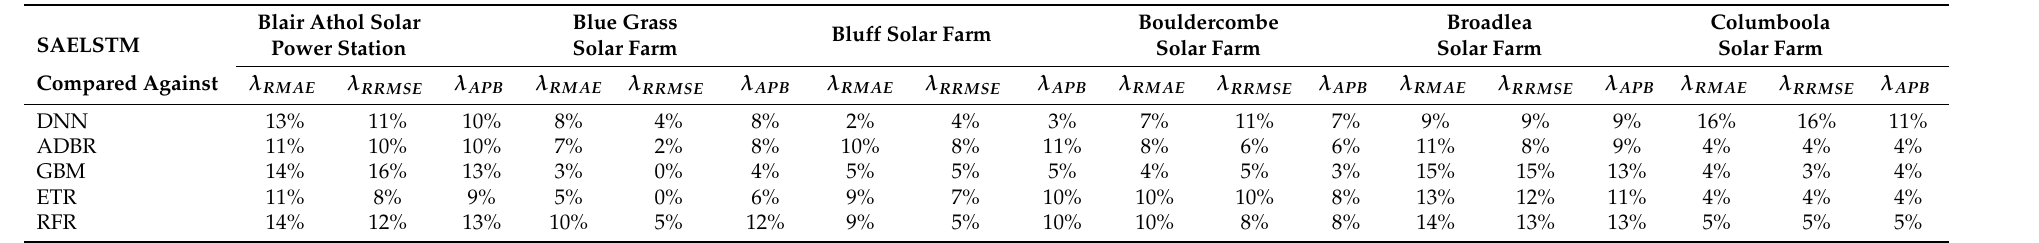
Table 8. The promoting percentage of comparison, against objective (i.e., deep learning hybrid SAELSTM) model with percentage values indicating the improvement of the objective model over the benchmark models. Note: λ RMAE is the promoting percentages of relative mean absolute error, λ RRMSE is the promoting percentages of relative root mean square error, and λ APB is the promoting percentages of absolute percentage